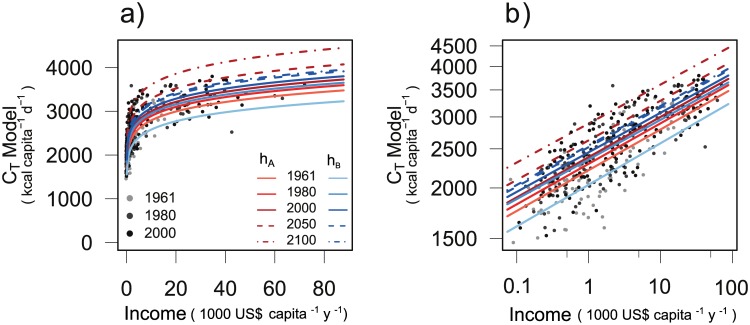
Model estimation for total calorie demand C
T with formulations g
A (red colors) and g
B (blue colors). Predictions for years 1961, 1980, 2000, 2050 and 2100 (lines) as well as reported data for 1961, 1980 and 2000 (dots) with a) linear axes scale and b) logarithmic axes scale.